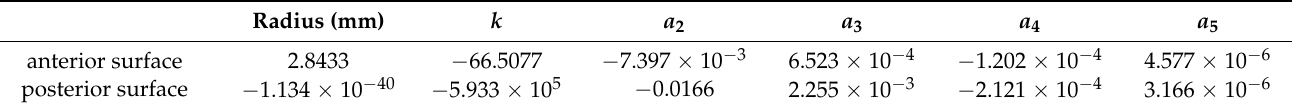
Figure 1. The cross-section profile of the effective optical zone of the optimized IOL. Table 3. The designed IOL surface parameters. Table 3. The designed IOL surface parameters.